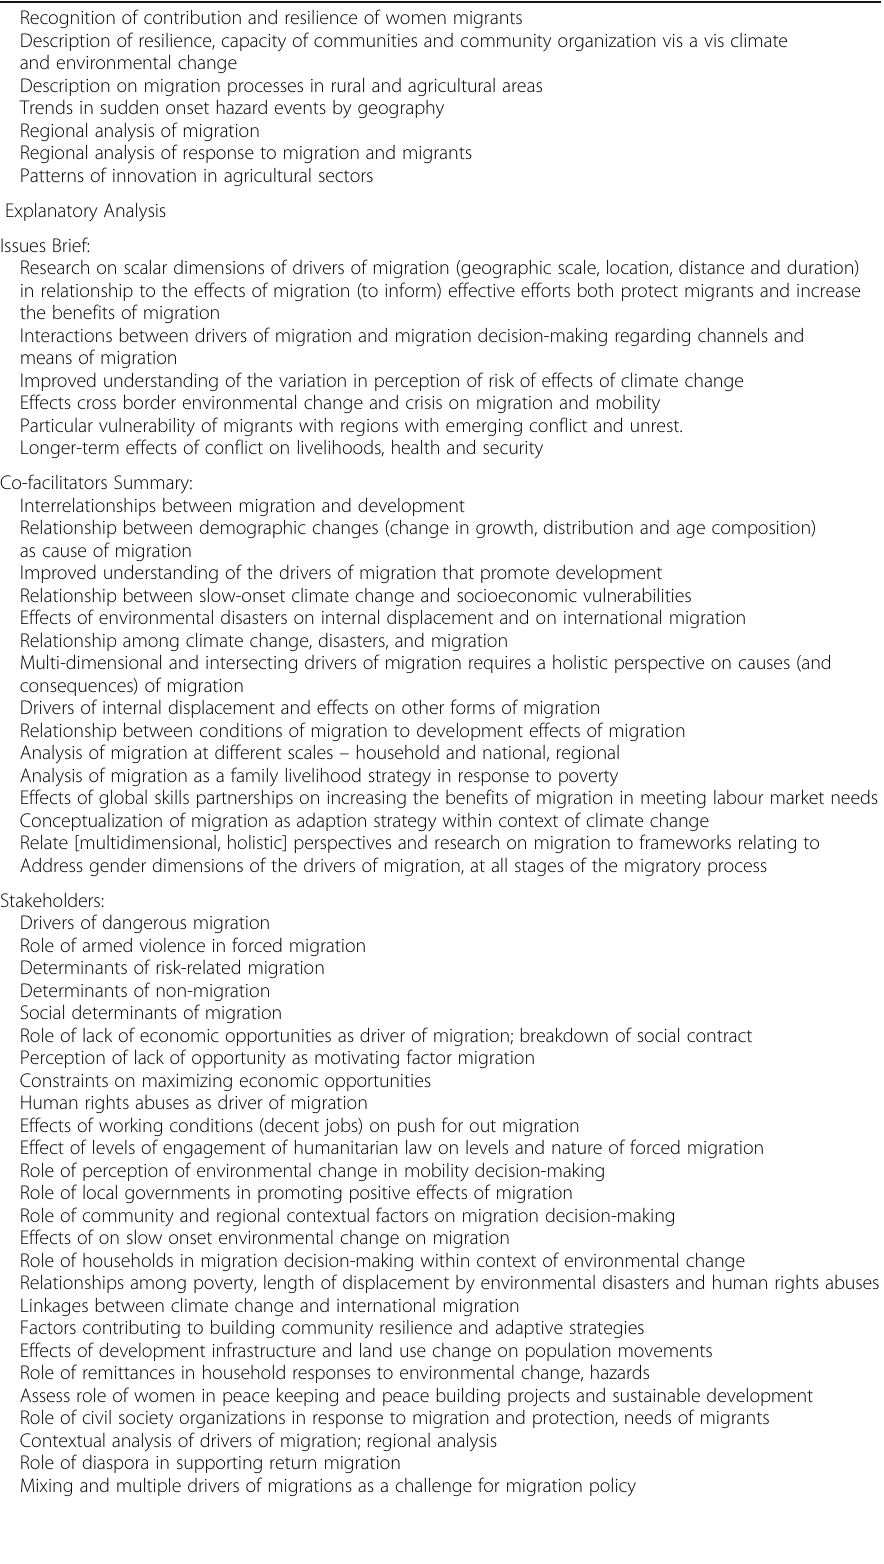
Table 2 Proposals for data and research: Thematic Session II Addressing drivers of migration, including adverse effects of climate change, natural disasters and human-made crises, through protection and assistance, sustainable development, poverty eradication, conflict prevention and resolution